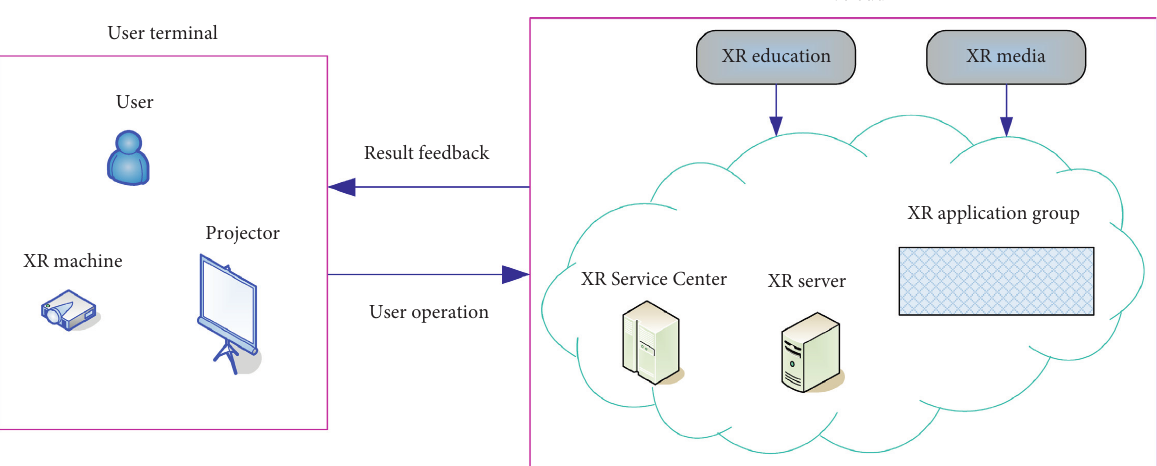
Figure 3: Organization structure diagram of XR cloud